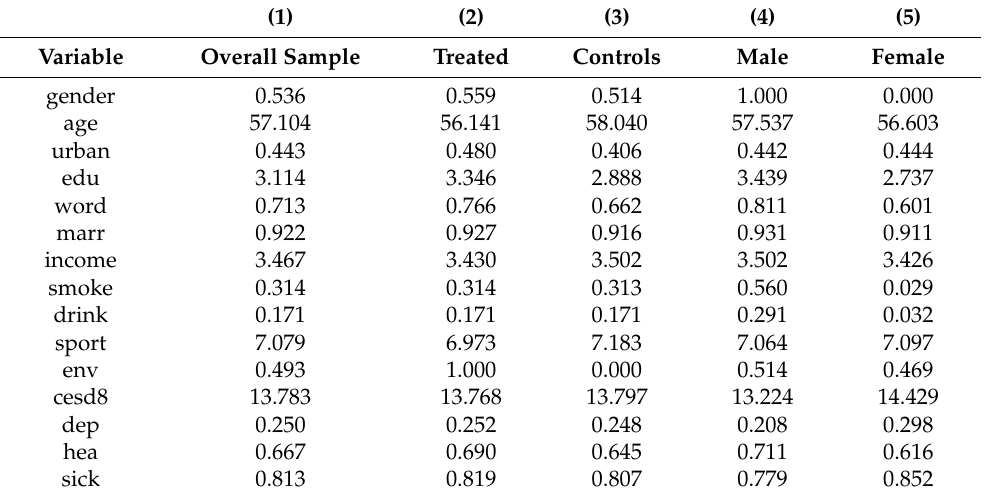
Table 2. Variable Descriptive Statistics.